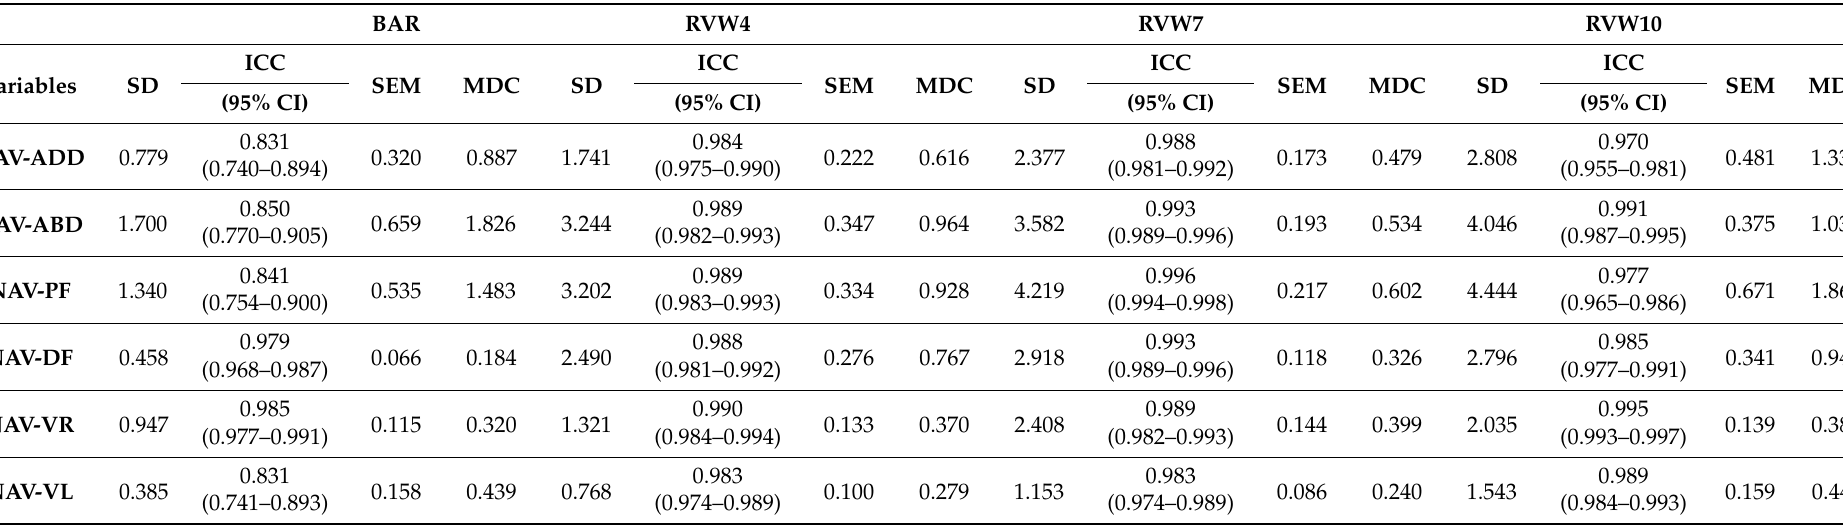
Table 3. ICC, SEM & MDC values of the navicular variables in barefoot condition and wearing rearfoot varus